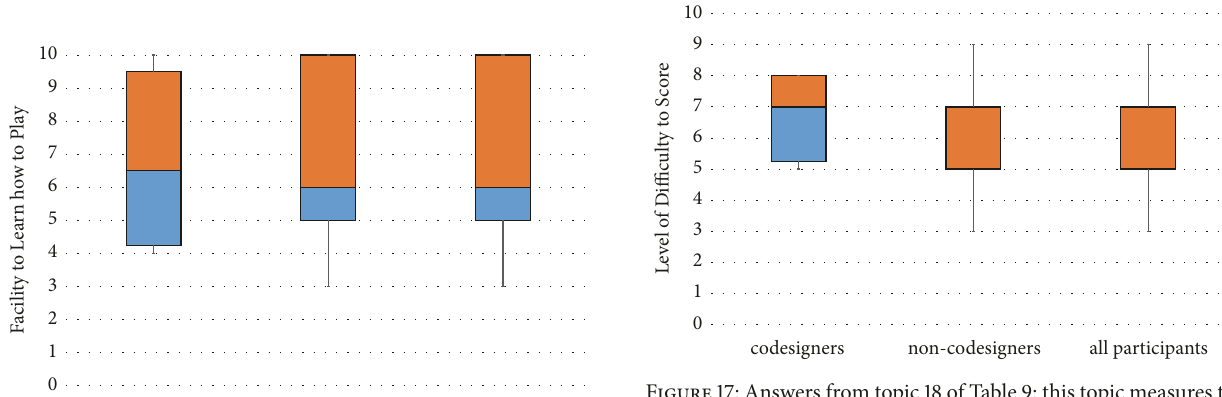
Figure 17: Answers from topic 18 of Table 9: this topic measures the facility of users to score in